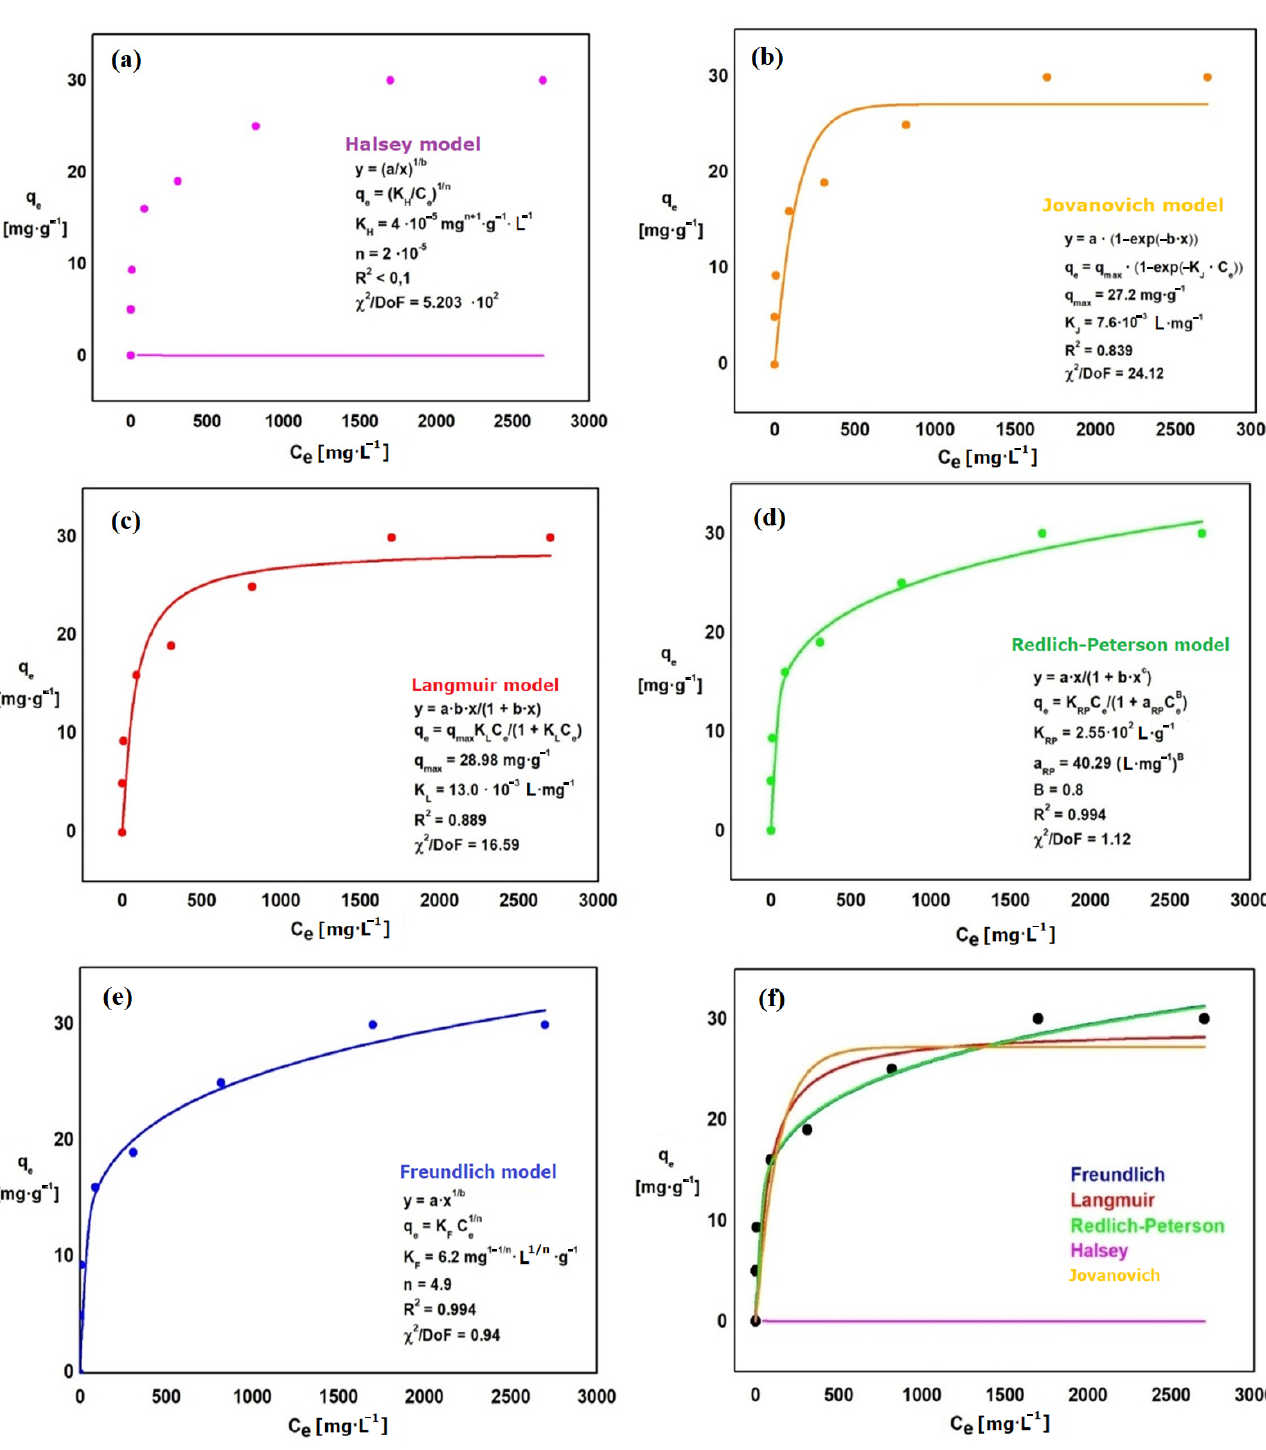
Figure 6. Isotherms: Halsey ( a ), Jovanovich ( b ), Langmuir ( c ), Redlich-Peterson ( d ), Freundlich ( e ), comparison of isothermal models for adsorbed phosphates ions ( f ).